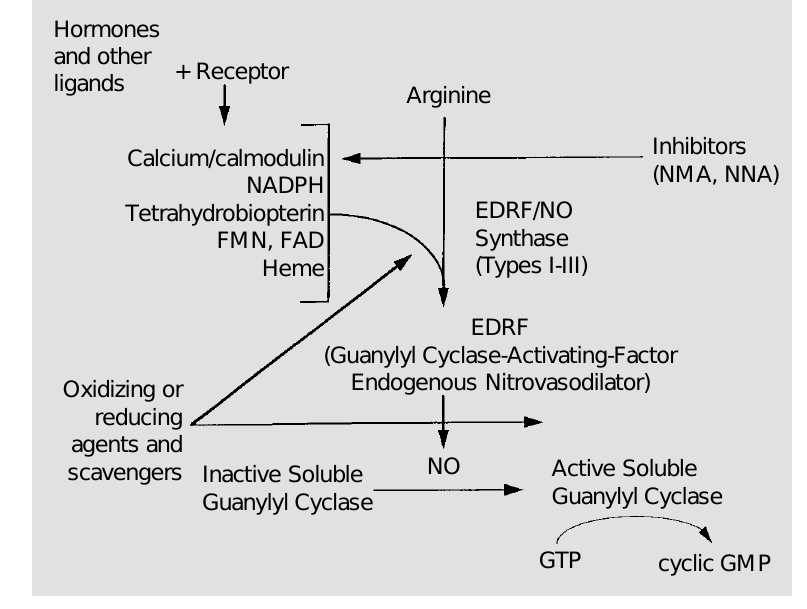
Figure 5 - Hormonal regulation of nitric oxide (NO) and cyclic GMP formation. NADPH, Nicotinamide adenine dinucleotide phosphate; FMN, flavin mononucleotide; FAD, flavin adenine dinucleotide; NMA, L-N-methyl arginine; NNA, L-N-nitro